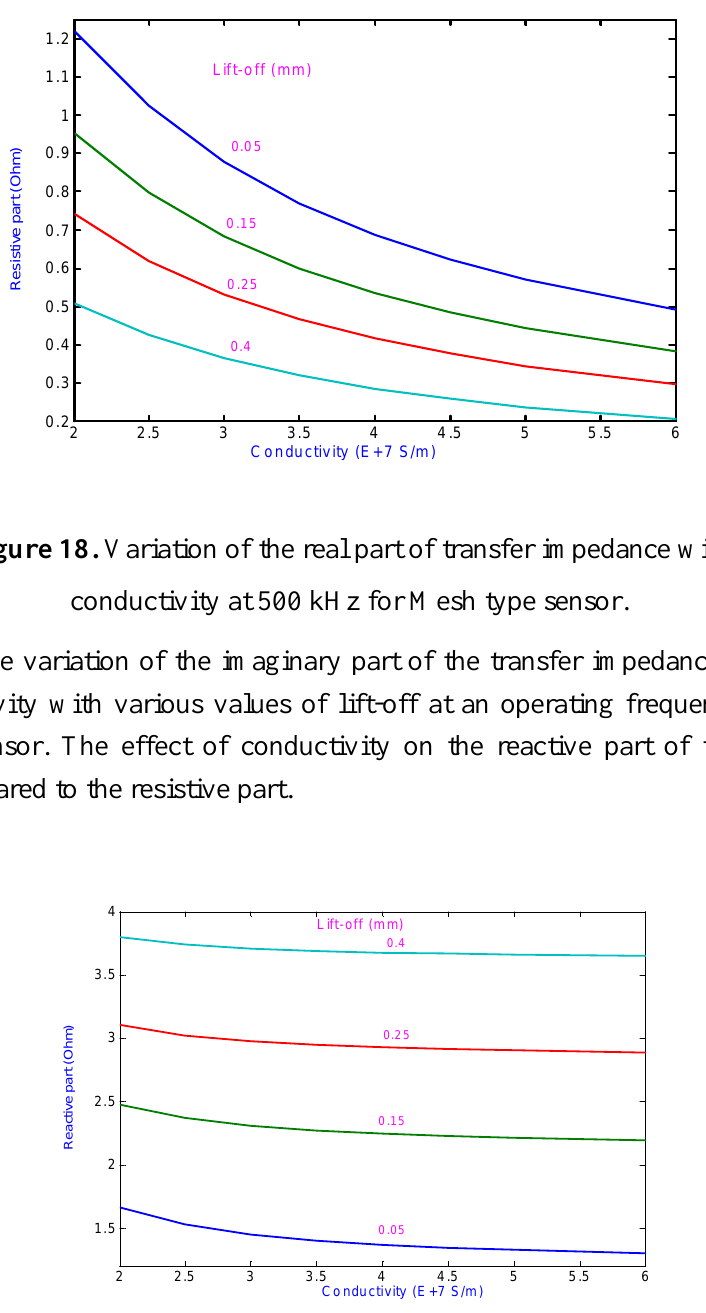
Figure 19. Variation of the imaginary part of transfer impedance with conductivity at 500 kHz for Mesh type